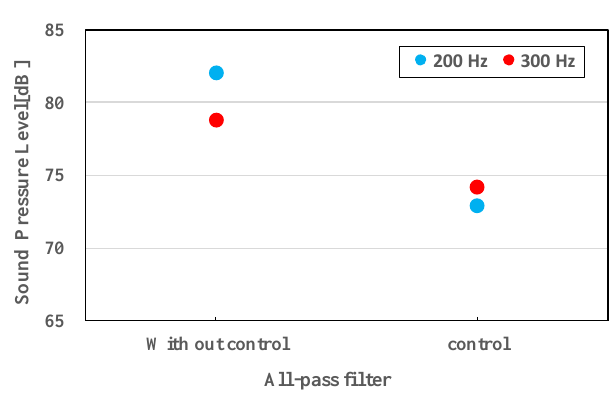
Figure 6. All-pass filter 300 Hz. Figure 6. All ‐ pass filter 300 Hz. Figure 6. All ‐ pass filter 300 Hz.